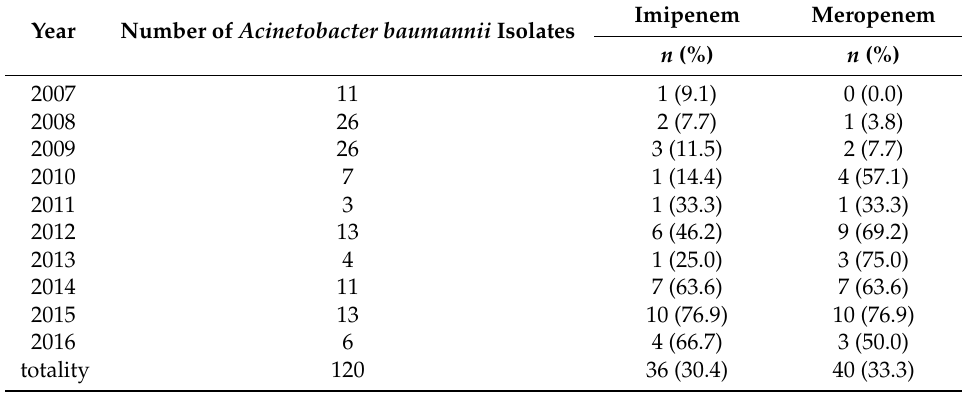
Table 7. Compilation of the number of Acinetobacter baumannii isolates resistant to carbapenems in the years